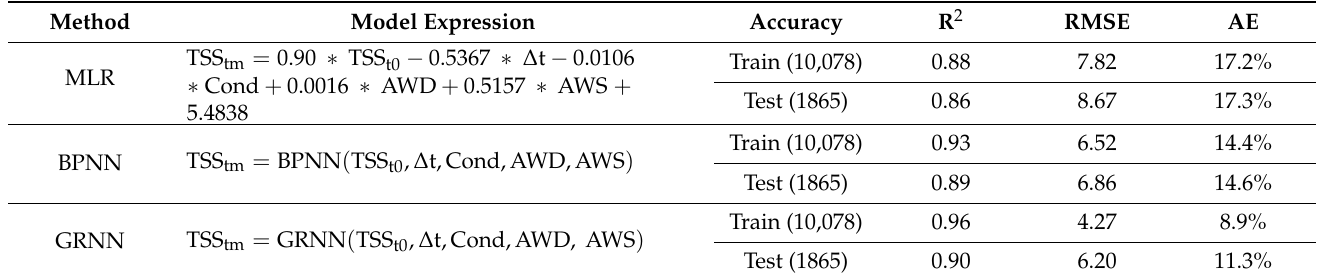
Table 4. Accuracy evaluation of multi-parameters forecasting models for all-valid